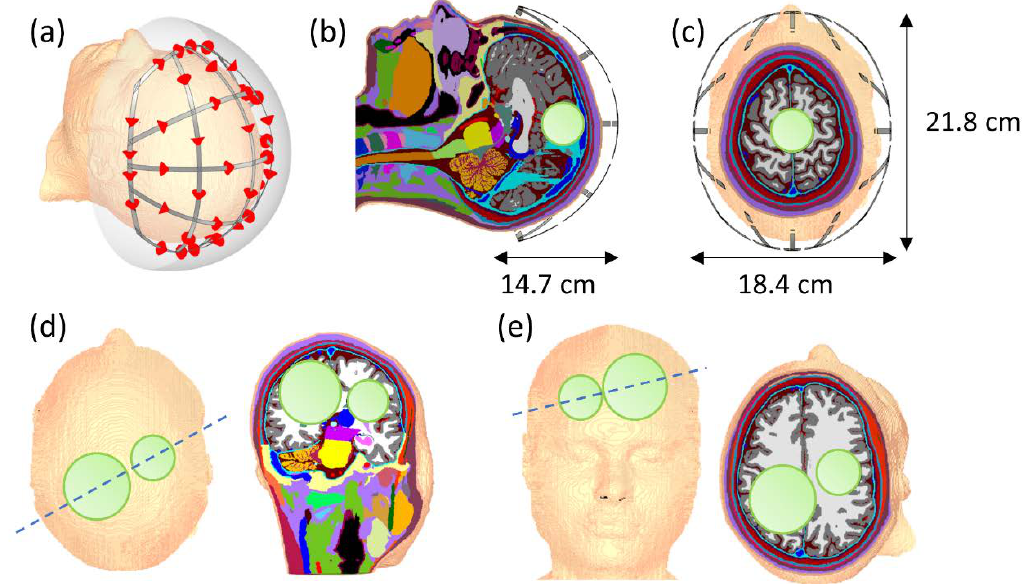
Figure 3. ( a ) Synthetic 40-channel helmet grid applicator for 3D evaluation of the proposed algorithm. The conductive paths conform to the contours of the head and can generate electromagnetic fields with varying polarizations. Simulated power sources are marked as red arrows. The RF applicator is shielded by a continuous conformal perfectly conducting shield positioned 2 cm away from the conductors (grey shaded area). ( b ) Sagittal and ( c ) coronal view of a spherical tumor (radius 2 cm) that was incorporated into the brain of the human voxel model and positioned at the center of the applicator (light green shaded area). ( d ) and ( e ) show oblique slices through the center of the second tumor model using two differently sized tumors (radius 2 and 3 cm).